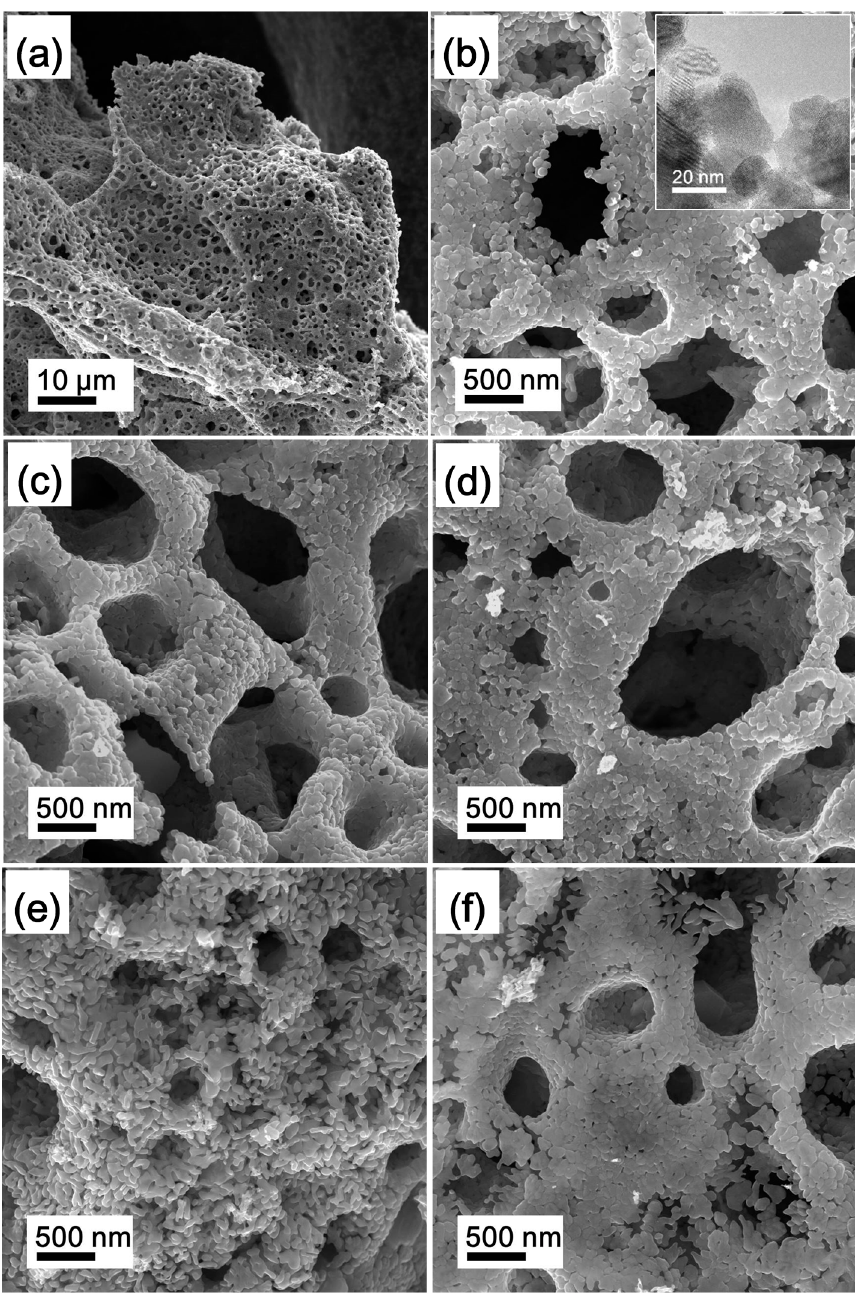
Figure 4. FE-SEM images of MoO 2 precursors for ( a , b ) P-LM0, ( c ) P-LM3, ( d ) P-LM6, ( e ) P-LM9, and ( f ) P-LM12; the inset of ( b ) shows the corresponding TEM image.